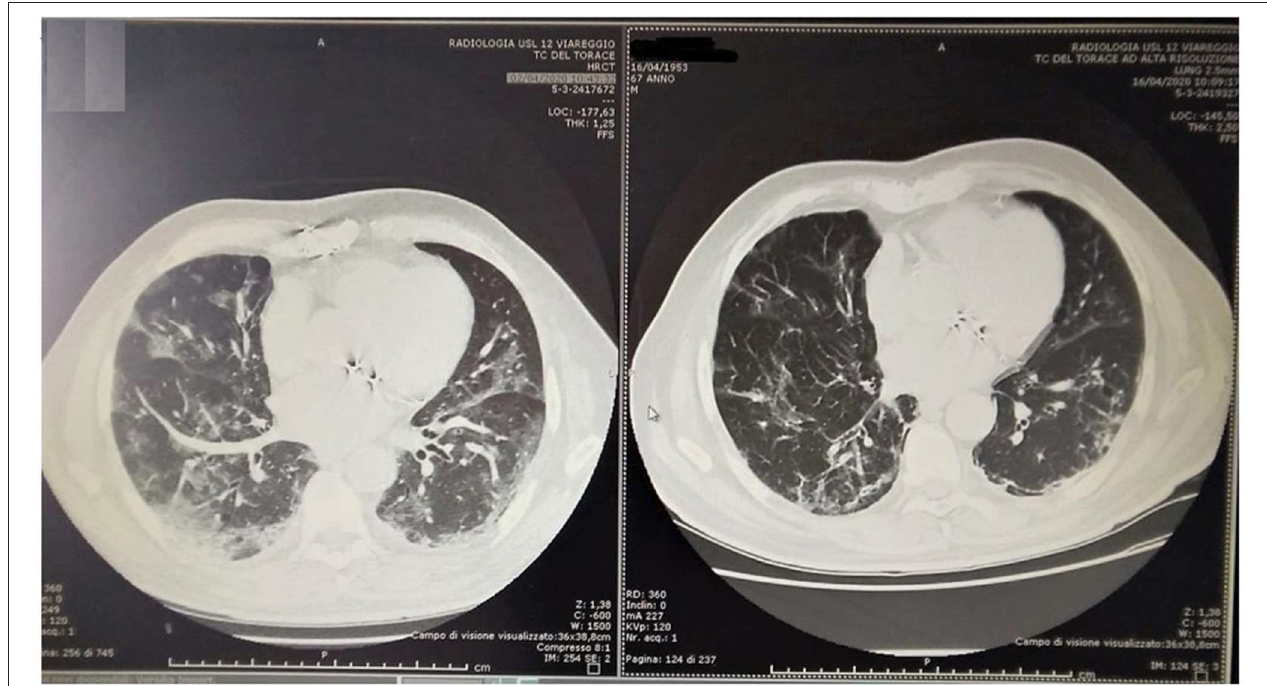
FIGURE 3 | CT chest in 67 years old patient at T0 (Left) and at day 14 of treatment (Right) .